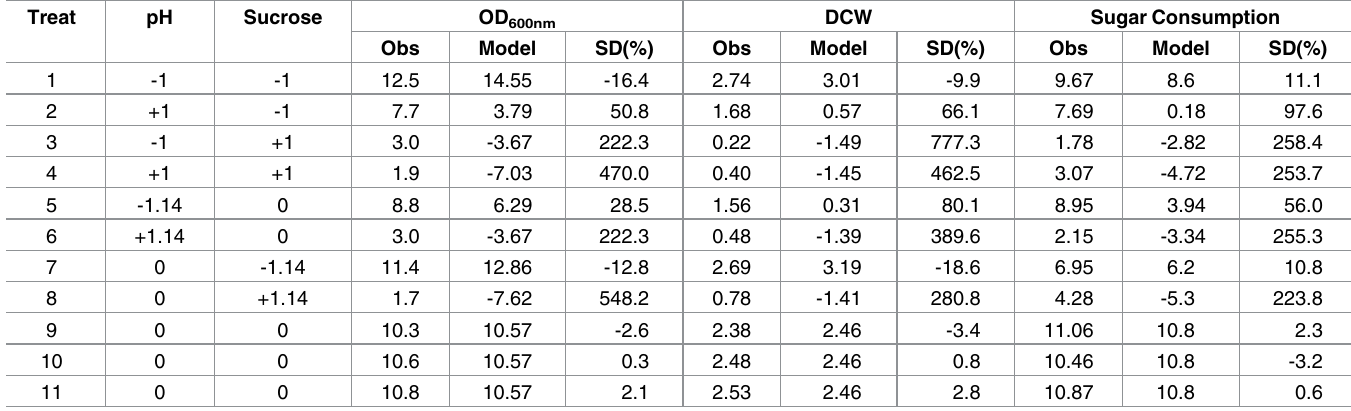
Table 5. Responses of the complete experimental design 2 2 for OD 600nm , DCW and sugar consumption, obtained from the inoculum of R . solana- cearum RS with glucose, experimentally observed and predicted by the model and their respective standard